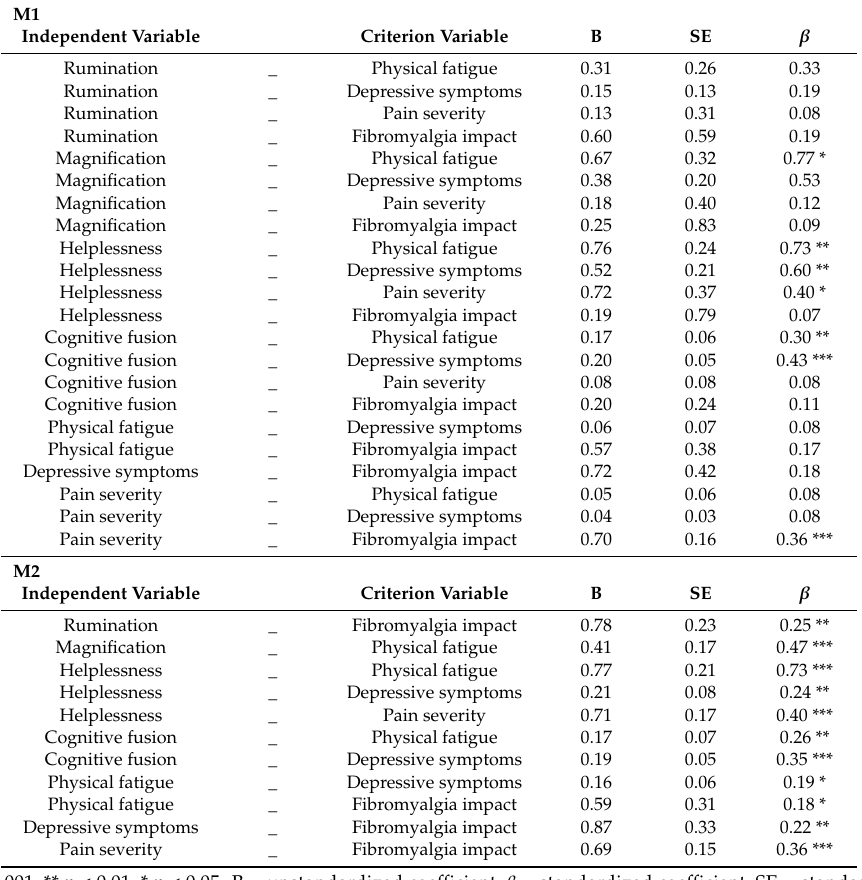
Table 3. Direct association estimates of the structural